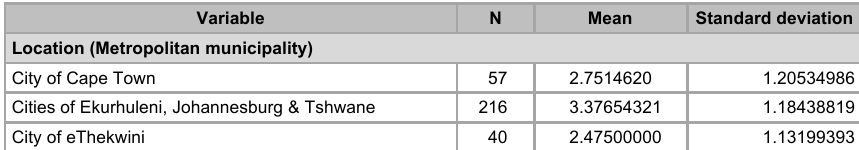
Variables that show significant differences regarding the outputs of the small business policy for the start-up / established business owners group Variable N Mean Standard